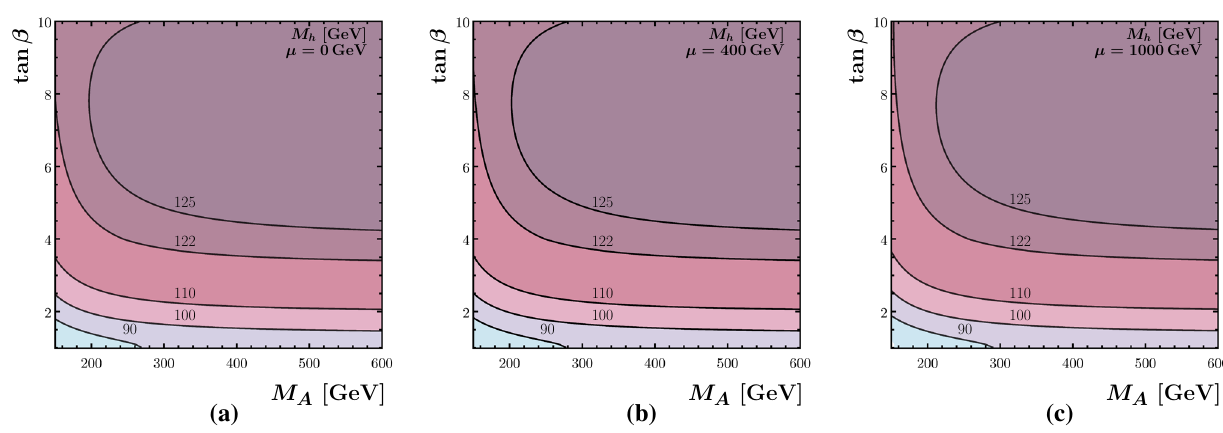
Fig. 2 Light Higgs mass M h in GeV as a function of M A in GeV and tan β for a μ = 0GeV, b μ = 400GeV and c μ =